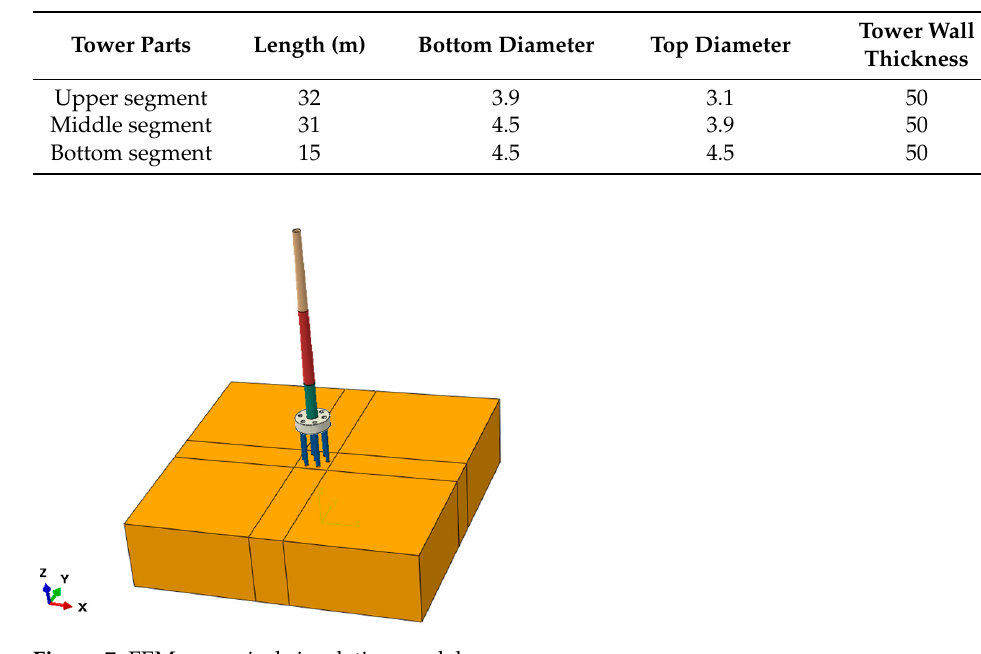
Table 1. Tower parameters.